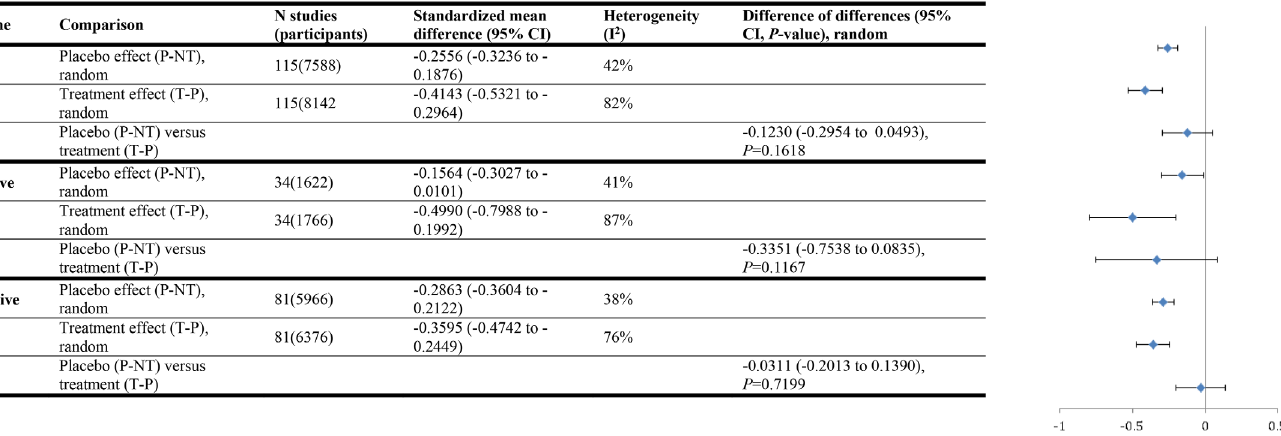
Fig 3. Placebo versus treatment effects (continuous outcomes)